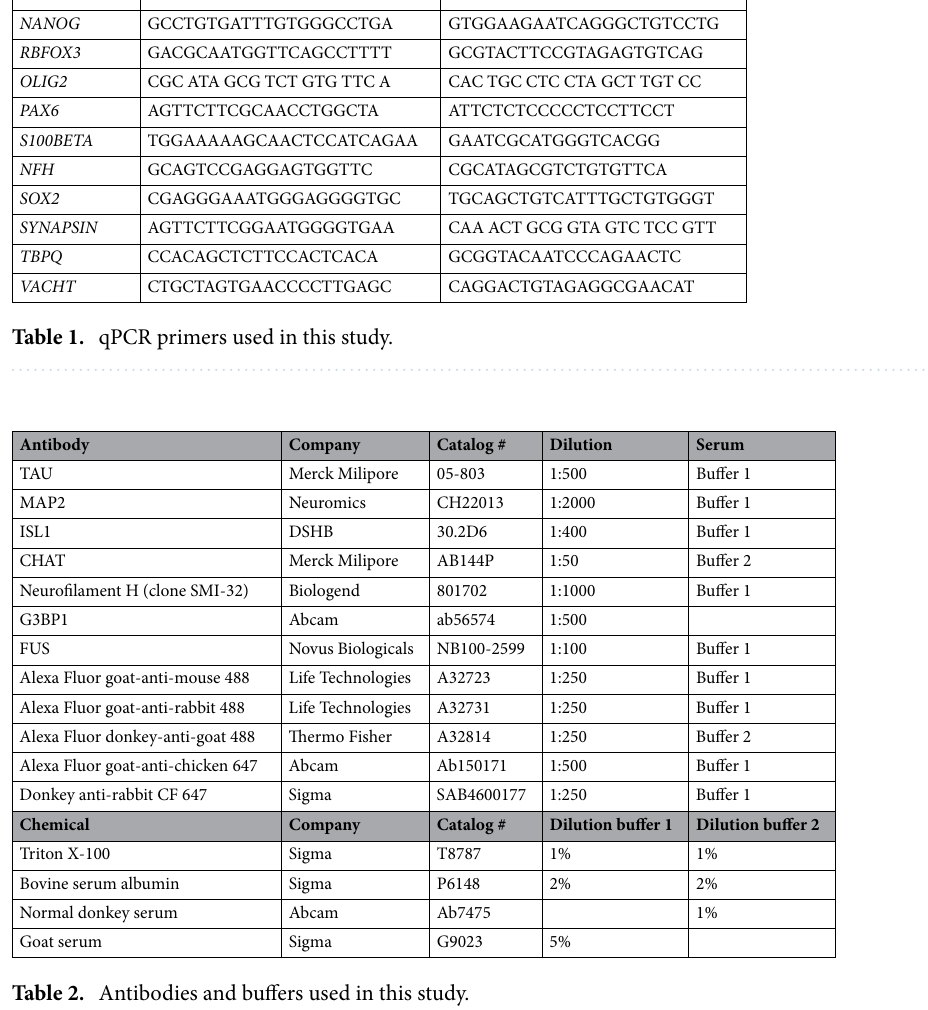
Table 2. Antibodies and buffers used in this study.